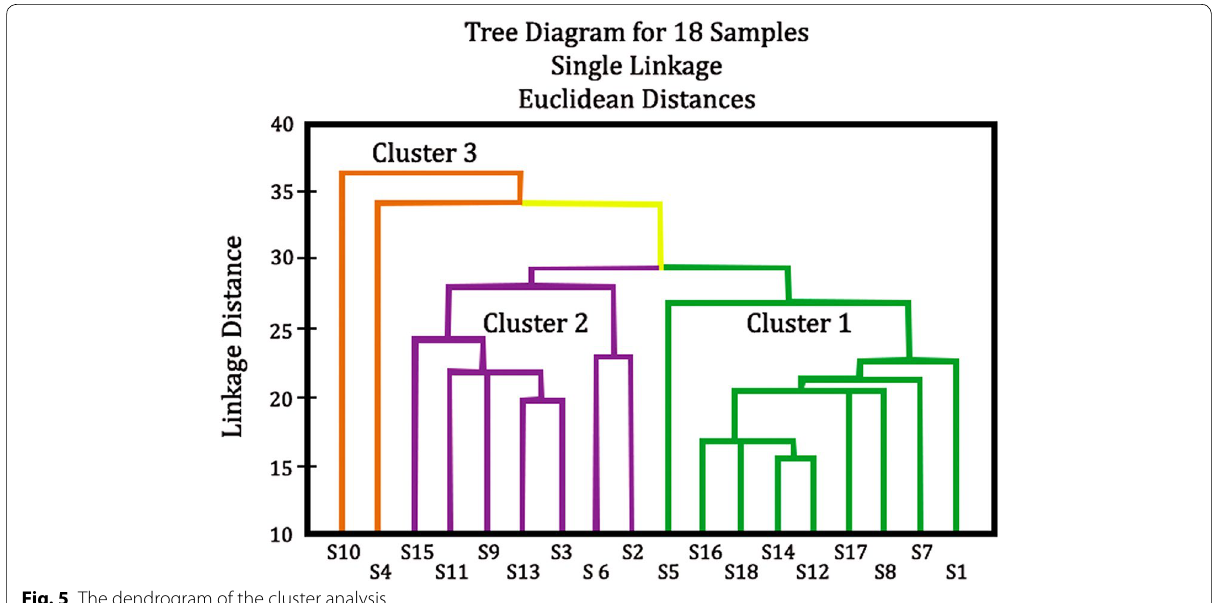
Fig. 5 The dendrogram of the cluster analysis